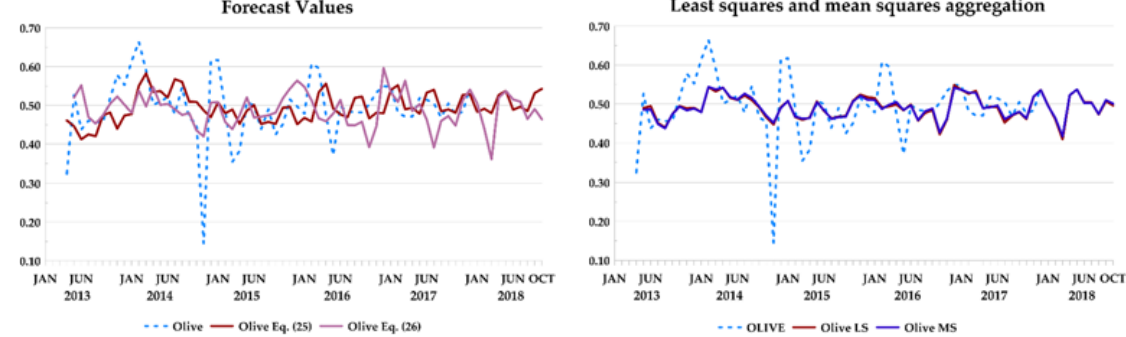
Figure 14. Forecast values for one-year time horizon given by the estimation models presented in Equations (25) and (26) and least squares and mean squares aggregation models.